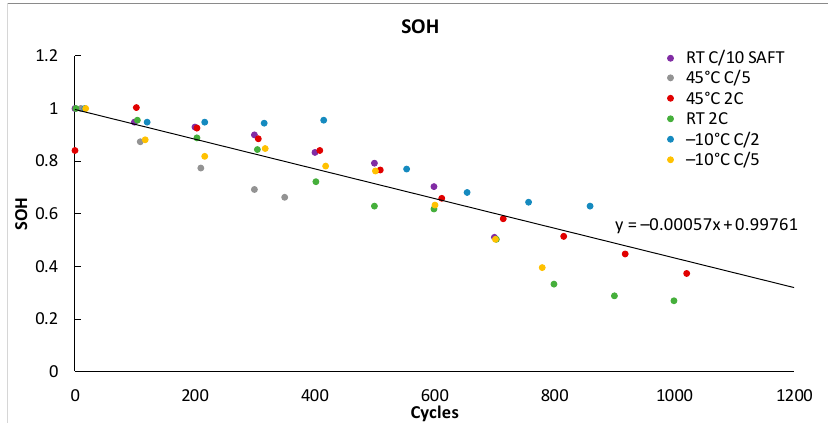
Figure 5. State of Health (SoH) evolution through cycling.